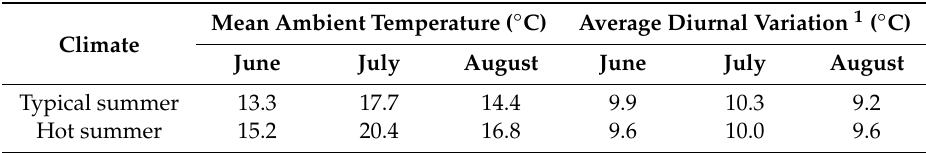
Table 8. The mean and average diurnal variation of ambient